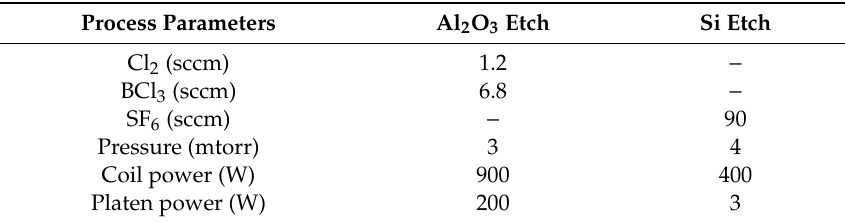
Table 1. Recipes for Al 2 O 3 and Si in etch